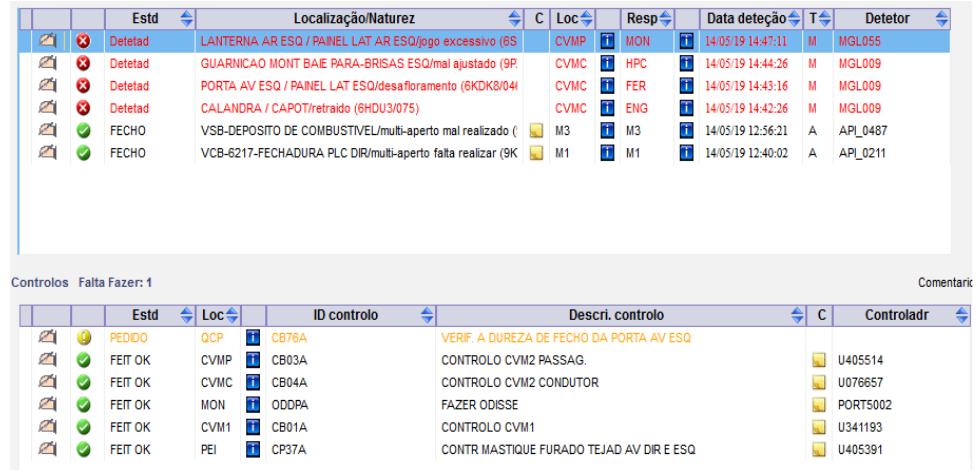
Figure 2. Screen from the final inspection station of the industry under study.